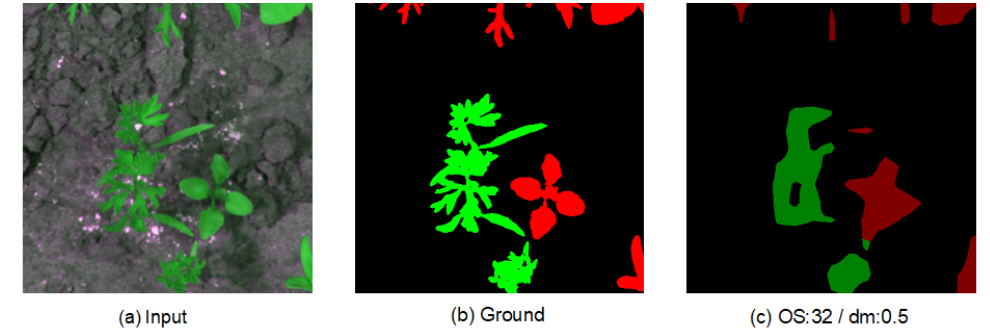
Figure 11. Qualitative segmentation result for input image resolution of 513 × 513, hyperparameter OS = 32. Table 13. Analysis of inference time with respect to the size of the input (s).